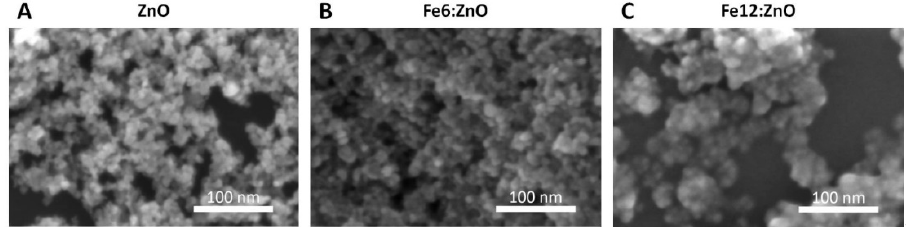
Figure 1. Field emission scanning electron microscopy images of ZnO ( A ), Fe6:ZnO ( B ) and Fe12:ZnO ( C ) nanoparticles having 0, 6 and 12 at.% of nominal iron doping, respectively.